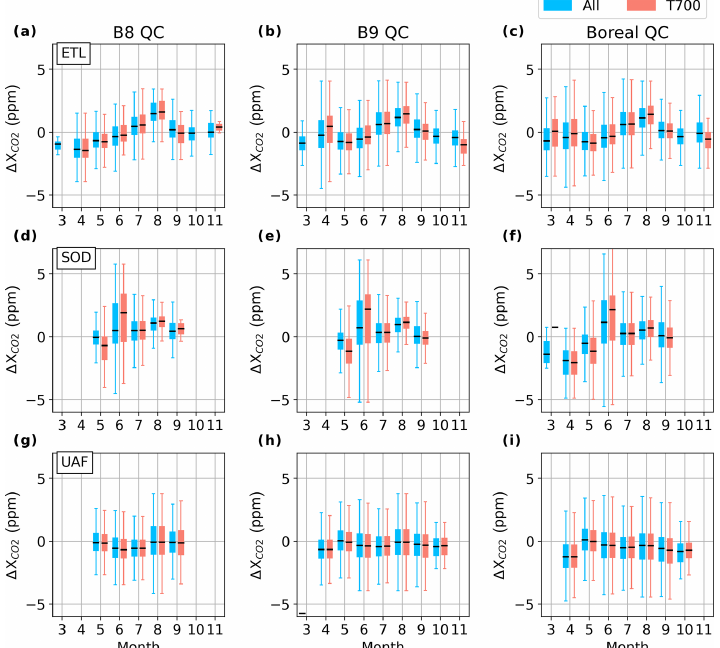
Figure B1. Monthly bias distributions for coincident OCO-2 retrievals filtered with boreal QC by comparing the full set of coincident retrievals (black) alongside a subset with the temperature at 700hPa (T700) in the OCO-2 retrieval equal to ± 1K of T700 from NCEP reanalysis at the ground site